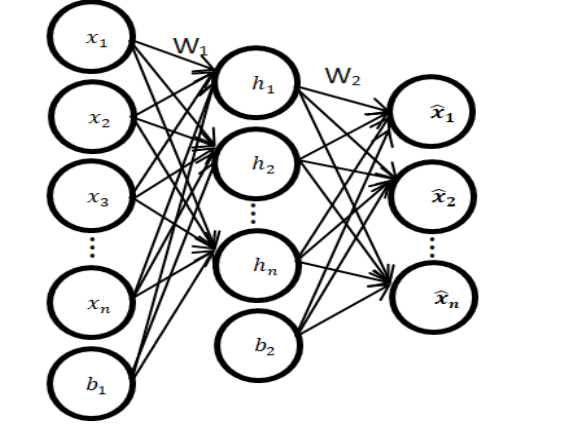
Figure 1. The structure of an autoencoder.